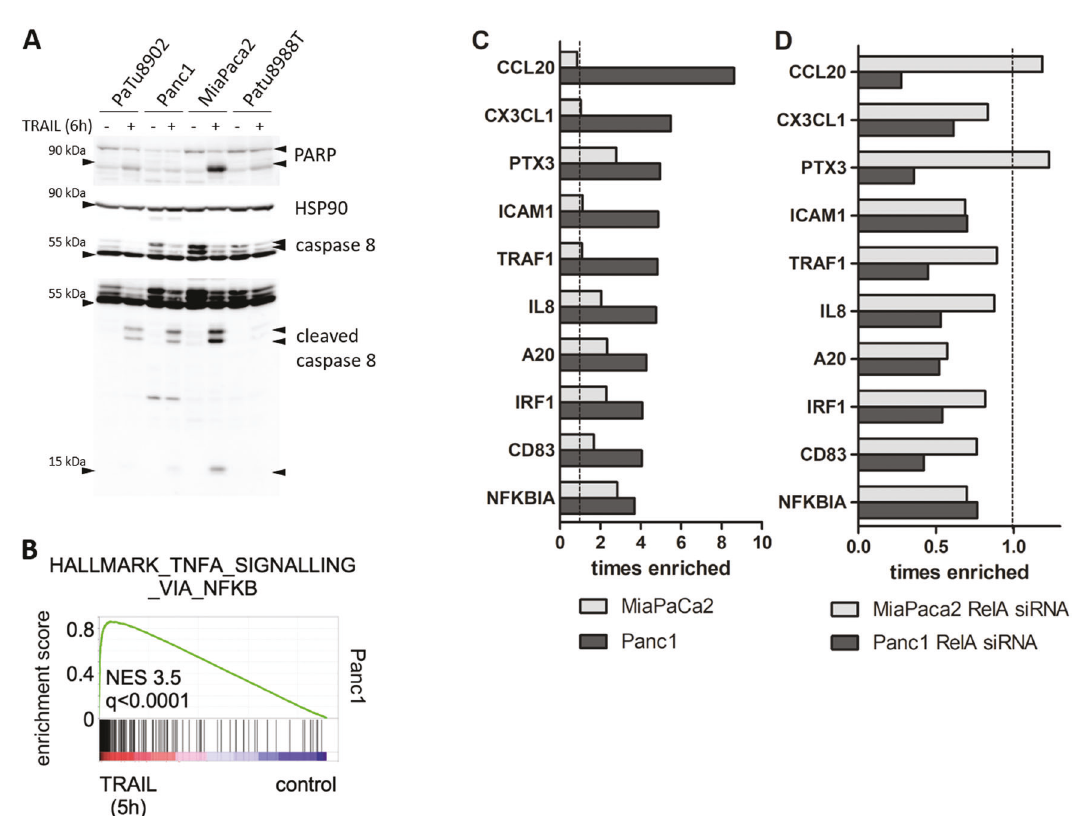
Fig. 1 A20 is a TRAIL inducible target gene in TRAIL-resistant PDAC cells. A Cells were treated with TRAIL for 6 h and whole-cell lysates were analyzed by western blot with indicated antibodies. HSP90 was used as a loading control. n = 5. B GSEA of RNA-Seq expression data from human Panc1 cells treated with 10 ng/ml TRAIL for 5 h. Depicted is the HALLMARK signature TNFA SIGNALLING VIA NF- κ B, including the q value. (C + D) PDAC cells were left untreated C or transfected with RelA-speci fi c siRNA D for 48 h. Afterward, cells were treated as described in B and a genome-wide array was performed. Top 10 differentially TRAIL-induced genes of a genome-wide expression array in Panc1 and MiaPaca2 cells, ranked by fold change are